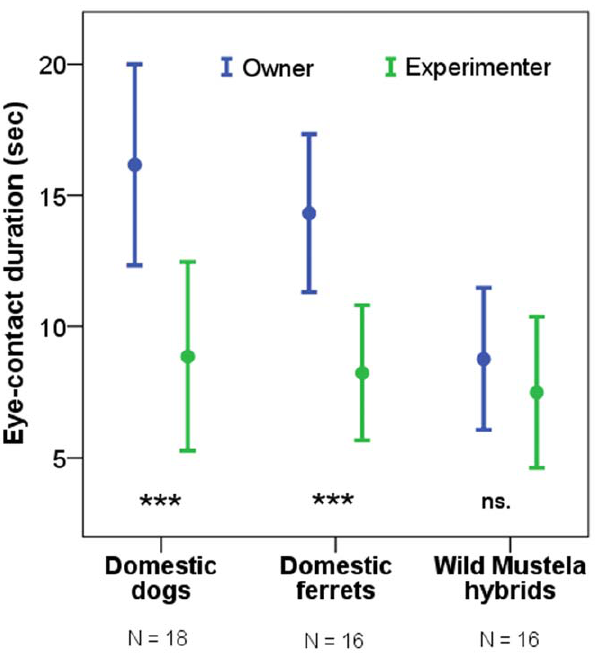
Figure 1. Tolerance of eye-contact. Mean duration of eye-contact during a 30 sec period while the subject was gently held by the owner or the experimenter without restricting head-movements. (***: p , 0.001, ns.: p . 0.05; error bars represent